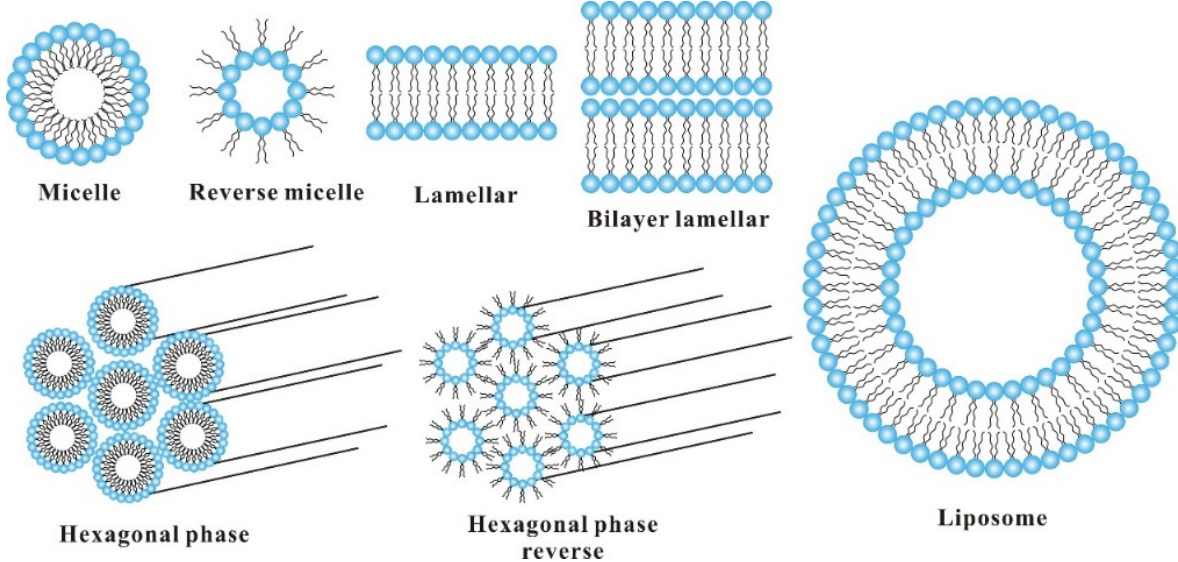
Figure 6. Diagrammatic presentation of various structures resulting from the self-assembly of phospholipids derived from soy lecithin.